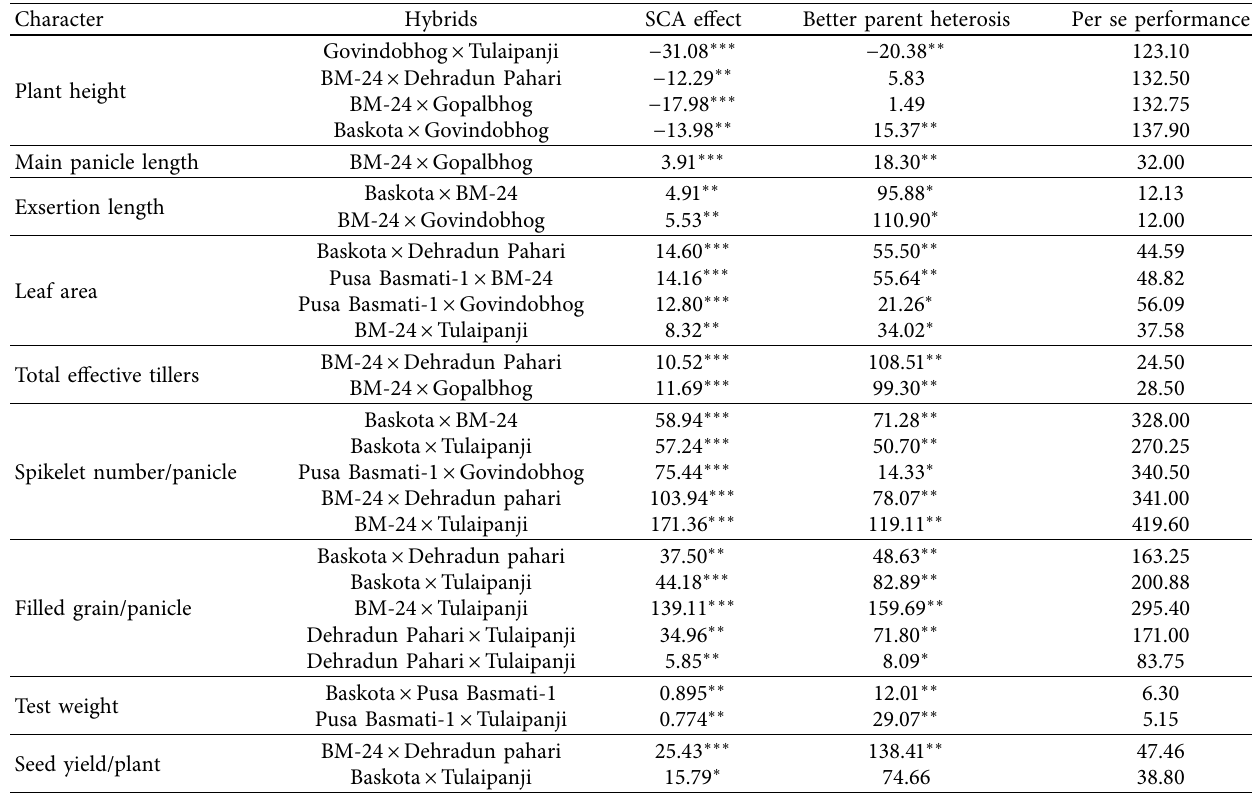
Table 7: Some of the best F